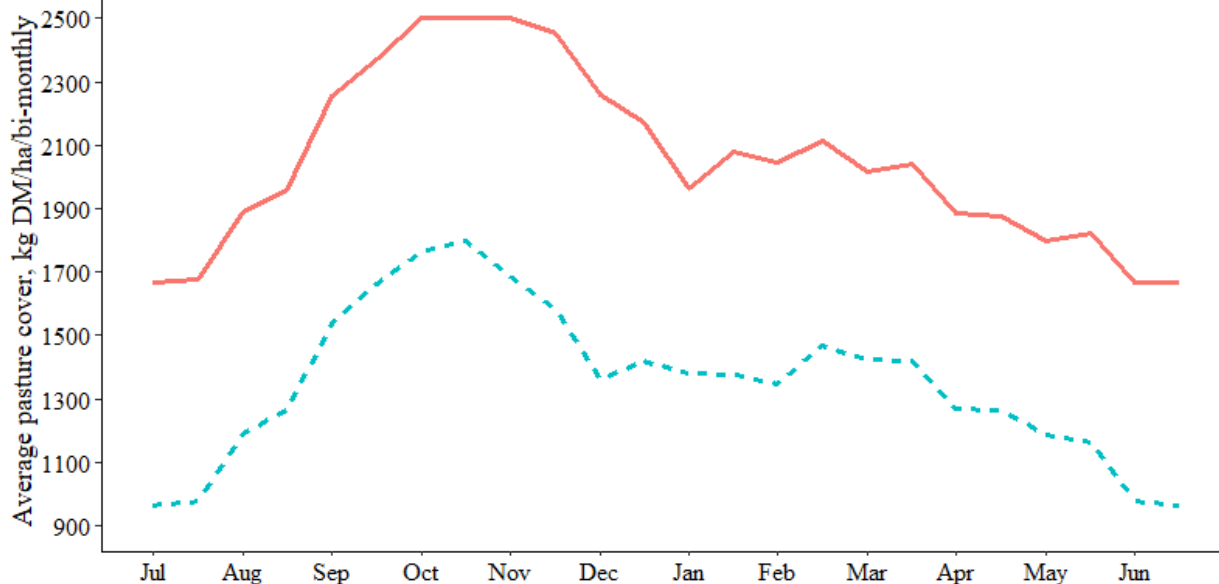
Figure 3. Bi-monthly average pasture mass (kg DM/ha/period) for beef cattle (orange solid line) and sheep (blue dashed line).